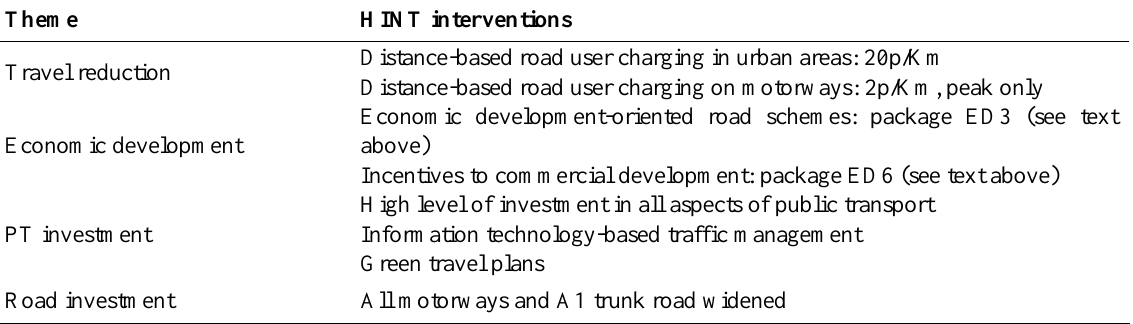
Table 1. Measures in HINT